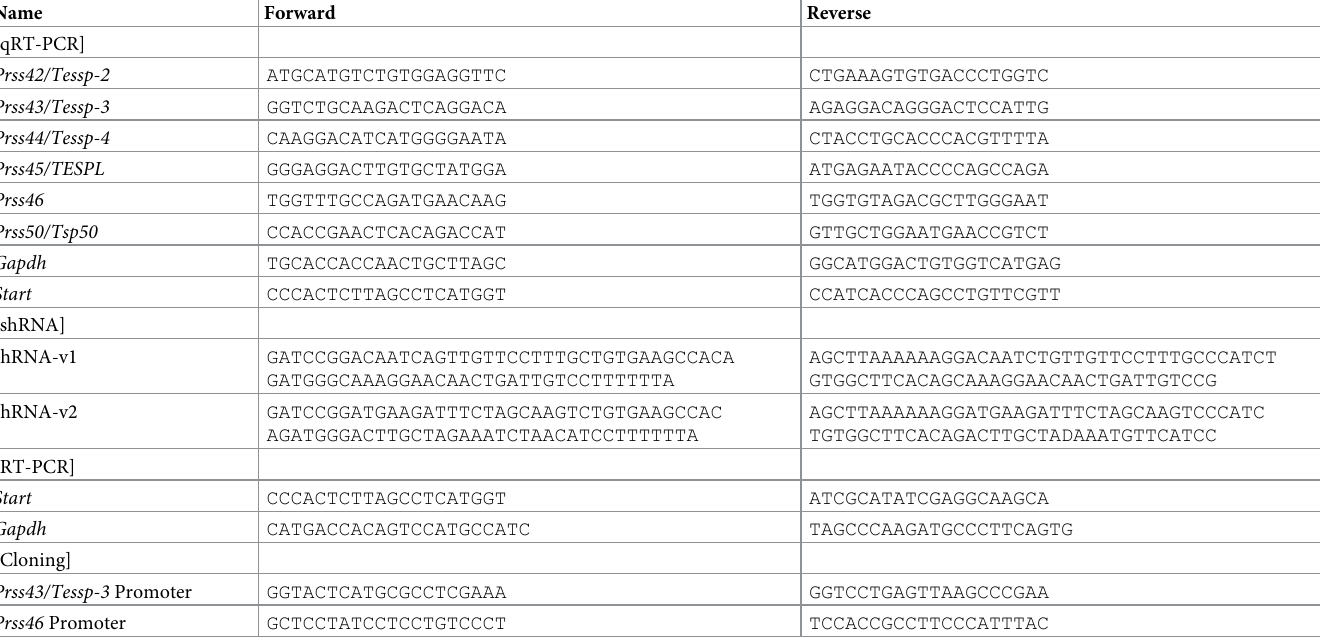
Table 1. Oligo DNA sequences used in this